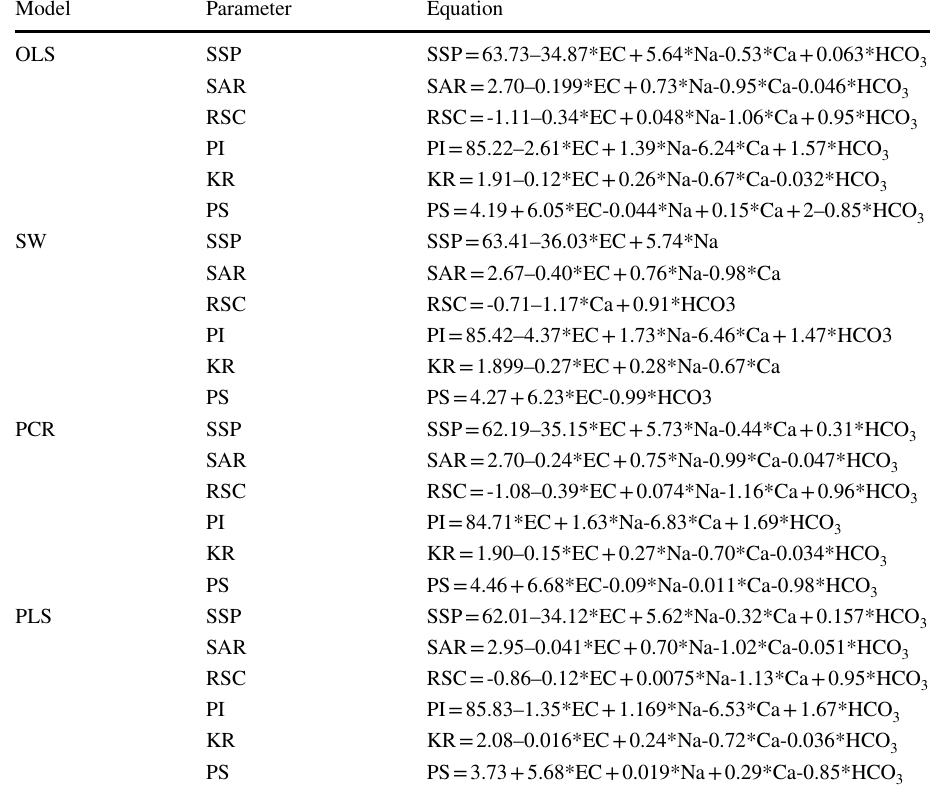
Table 4 The regression equations established between the water quality indices and the chemical composition